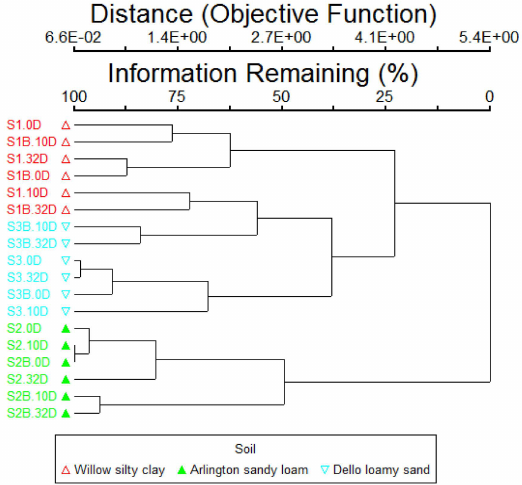
Figure 5. A comparison of the fungal community structure of cluster dendrogram by using PCORD. Figures next to the branches are the cophenetic correlations value that is a parameter to express the consistency of a cluster. (S0D, S10D and S32D indicate soils untreated and sampled in 0, 10 and 32 day. SB0D, SB10D and SB32D indicate B subtilis B068150 was introduced in to soils and sampled in 0, 10 and 32 days).